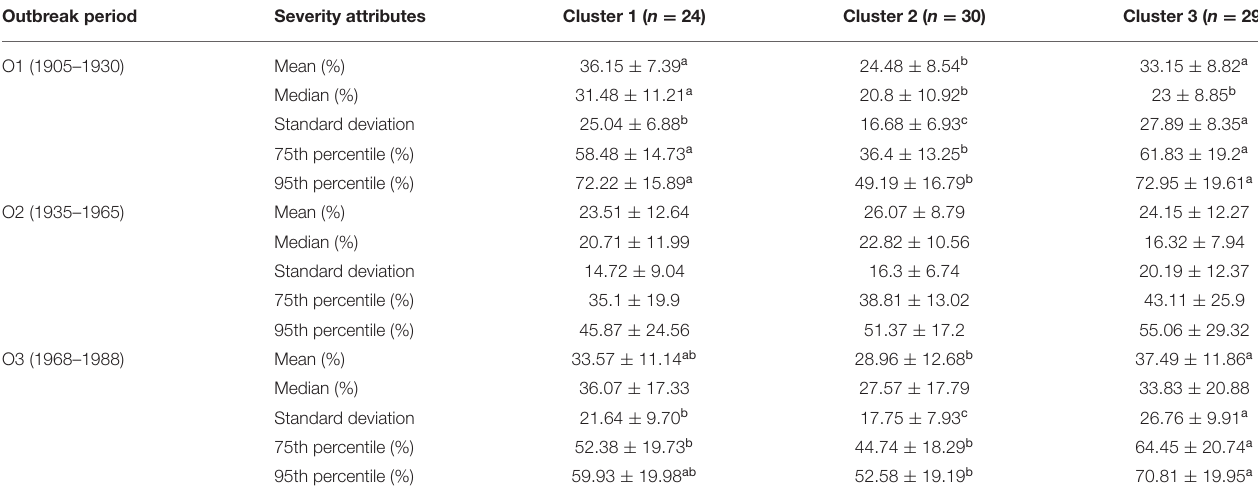
TABLE 2 | Mean and standard deviation of severity attributes (mean, median, 75th and 95th percentile of the percentage of trees affected by SBW for each of study sites and outbreak period) between clusters for each SBW